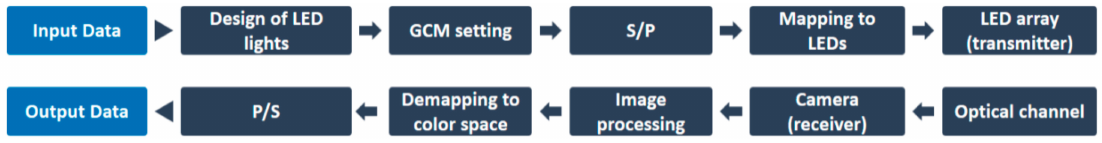
Figure 12. GCM-based visual MIMO transceiving process including the design of LED lights